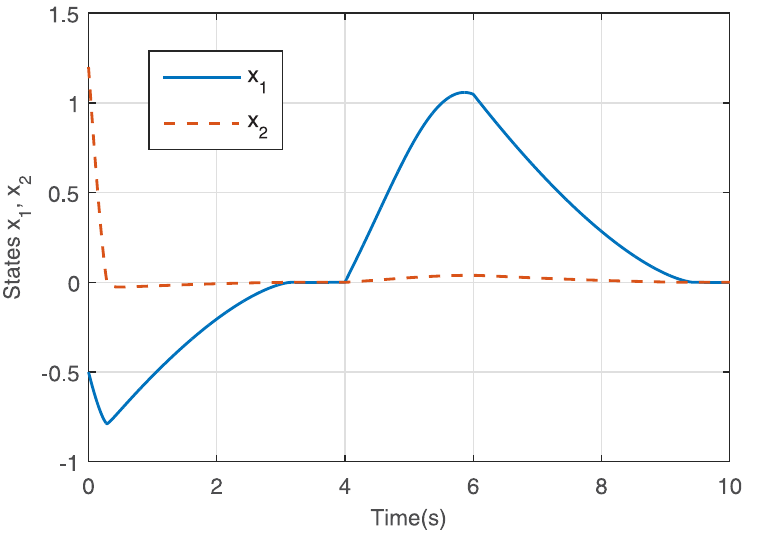
Fig 6. States x 1 and x 2 with disturbance and without sat ( u